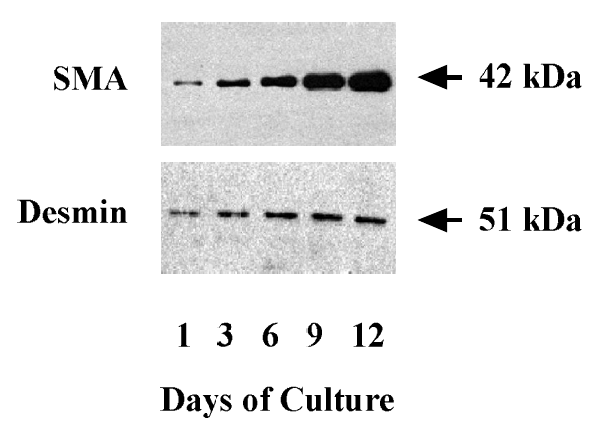
Figure 2 Expression of SMA and desmin in sub-cultured HSCs. Hepatic stellate cells were isolated from Sprague-Dawley rat and cultured for 9 days. Cells were then incubated with trypsin and sub-cultured for days indicated. The upper panel represents abundance of SMA while the lower panel repre- sents abundance of desmin.